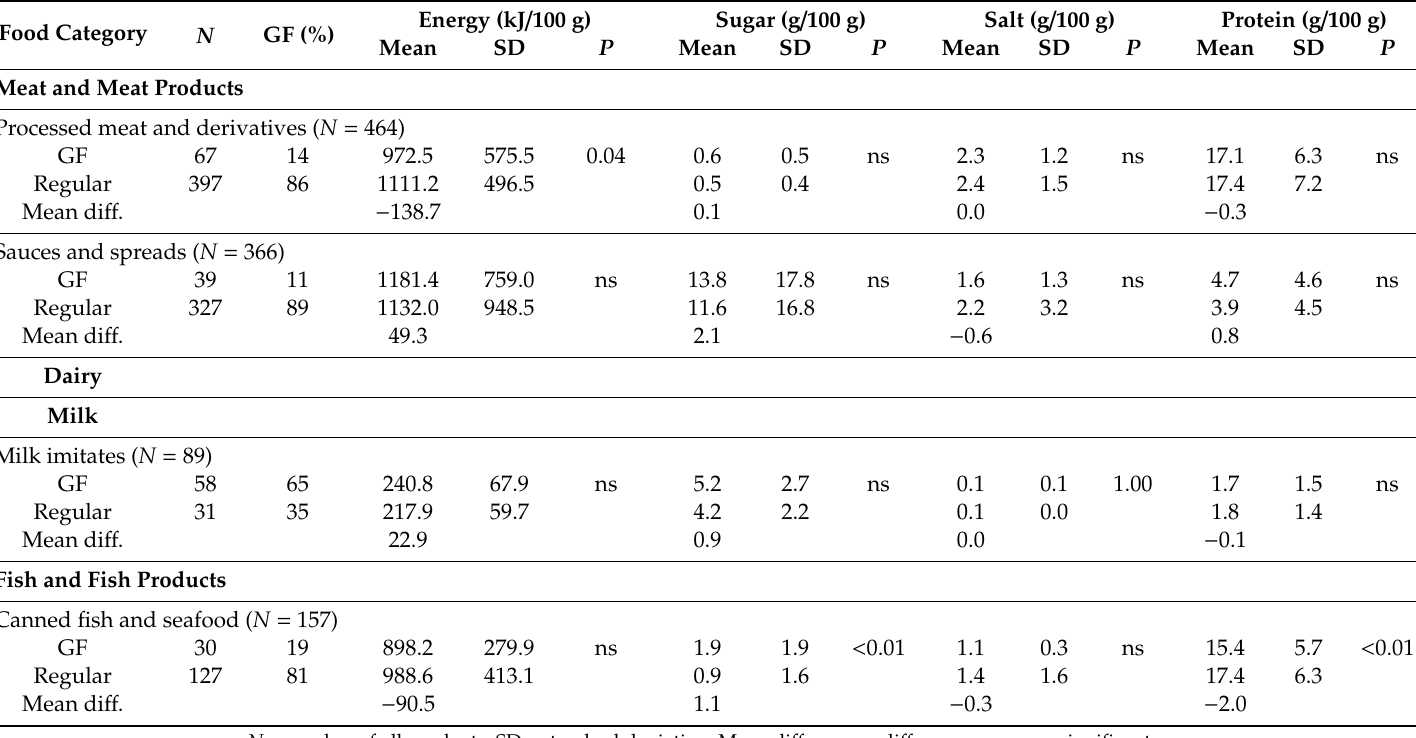
Table 2. Gluten-free (GF) labelled non-cereal products and the comparison of energy content and certain nutrients in GF-labelled vs. regular products for selected food